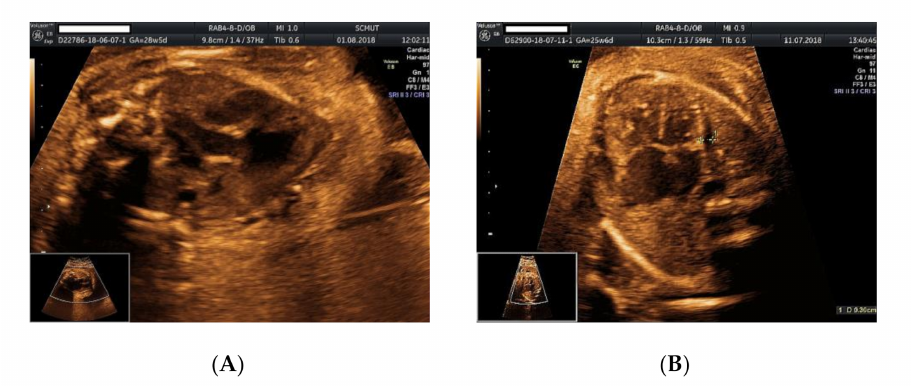
Figure 2. Ultrasound examination of the fetus: ( A ) malalignment of the three-vessel view with vena cava located above the aforementioned plane, enlarged right atrium, no foramen ovale, no interatrial septum; ( B ) pericardial e ff usion, no atrial septum, no patent foramen ovale